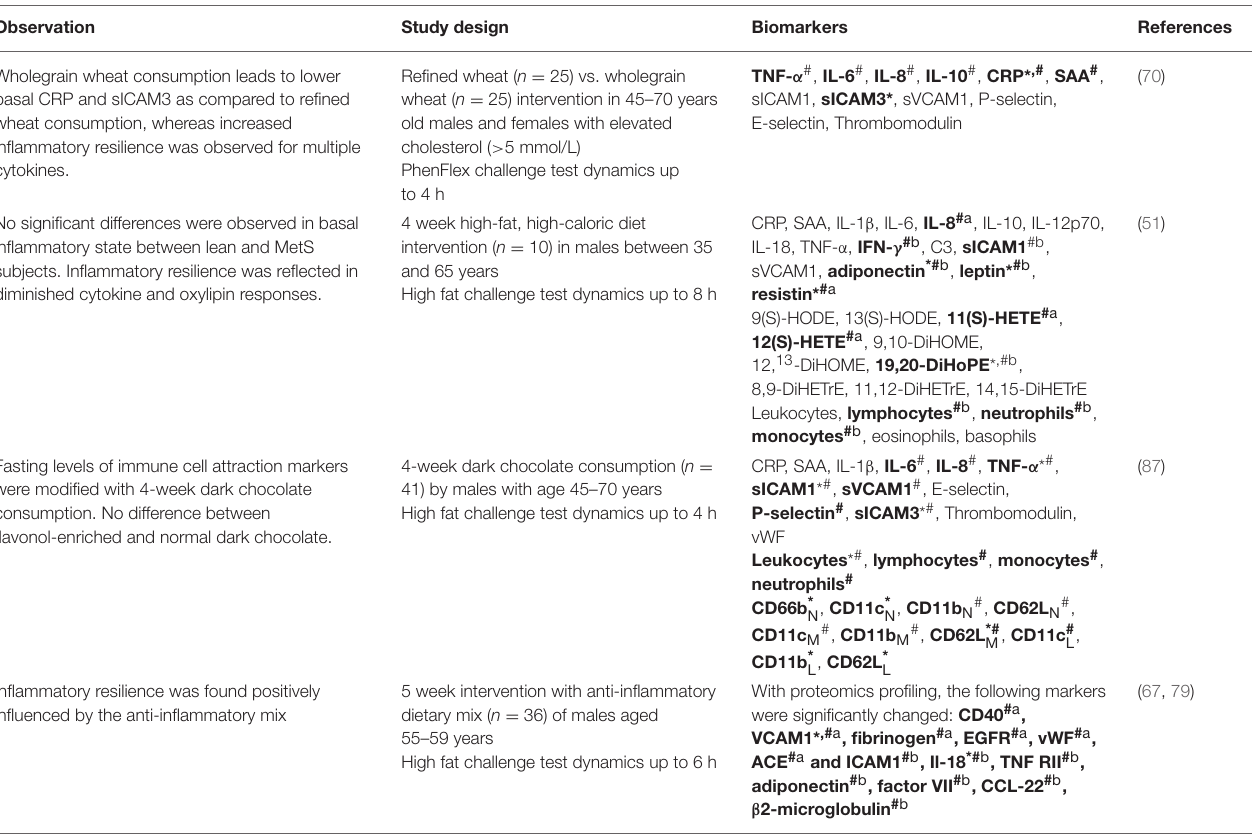
TABLE 3 | Metabolic challenge test to evaluate nutritional effects on chronic low-grade inflammation. Observation Wholegrain wheat consumption leads to lower basal CRP and sICAM3 as compared to refined wheat consumption, whereas increased inflammatory resilience was observed for multiple